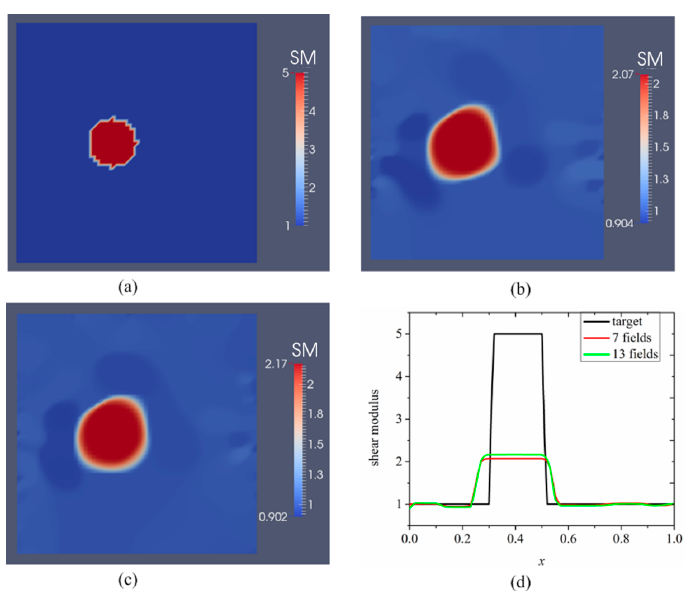
Figure 2. Shear modulus reconstructions for 0.1% noise. ( a ) target shear modulus distribution for comparison; ( b , c ) reconstructed shear modulus distribution using 7 and 13 boundary displacement data sets, respectively; ( d ) shear modulus plot over the horizontal line through the center of the inclusion for the target and reconstructed shear modulus distribution (unit in the scale bar: 10 kPa). Note: “SM” stands for shear modulus.